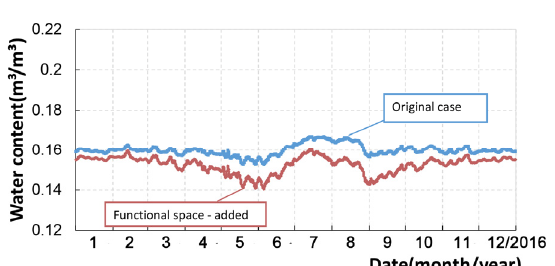
Figure 16. Point 3—water content change.